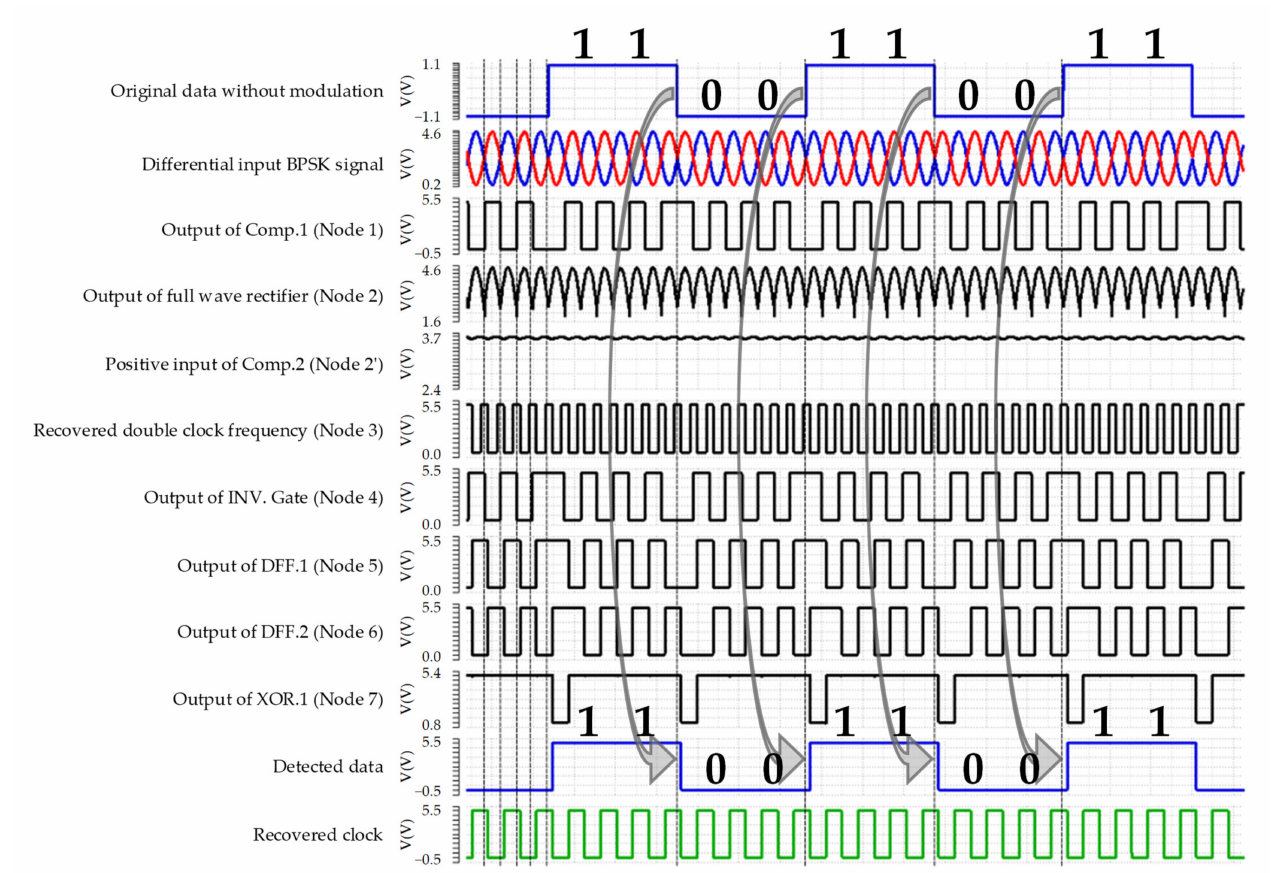
Figure 5. Simulated timing diagram of the proposed non-coherent DBPSK